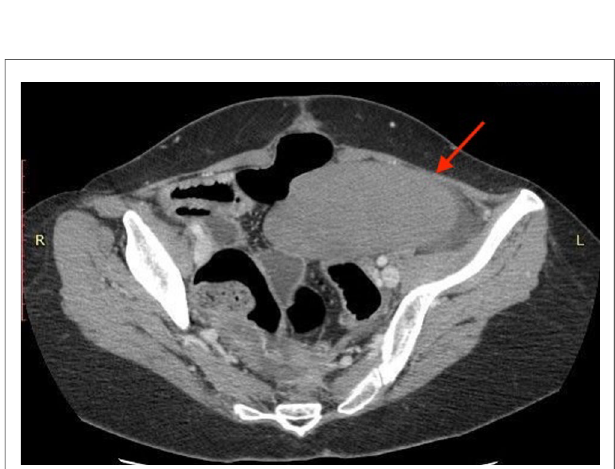
FIGURE 3 | Marked overdistension of loops with contralateral dislocation of heart and middle-inferior mediastinum.